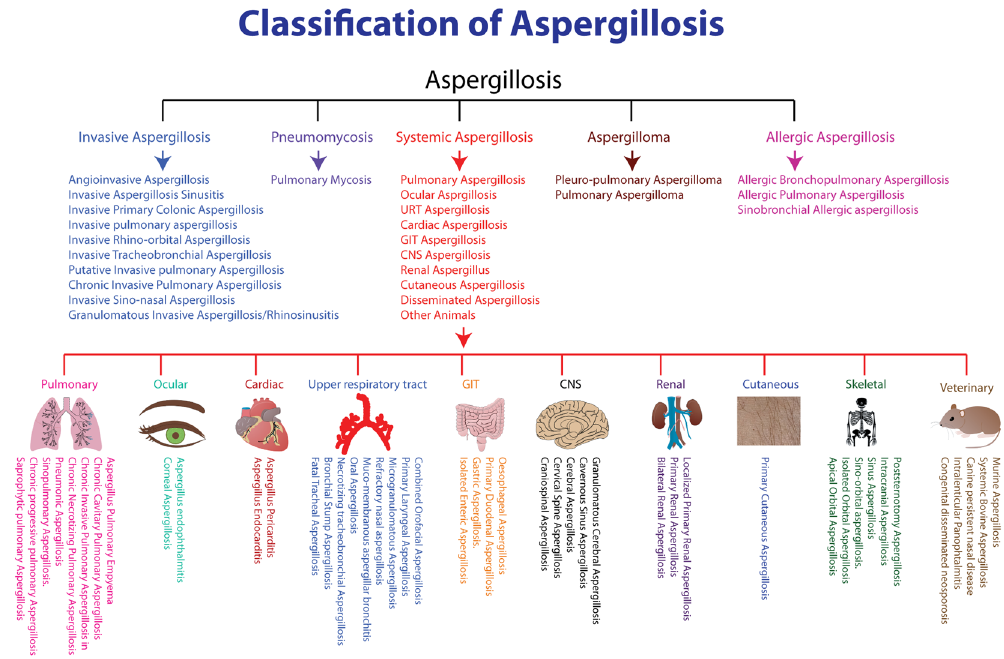
Figure 5. A detailed classification of Aspergillosis with case reports and related images from the literature available so far from humans and animals with DOI literature references. All the organ systems have been drawn using the software Edraw (Version 8.6) trial version.